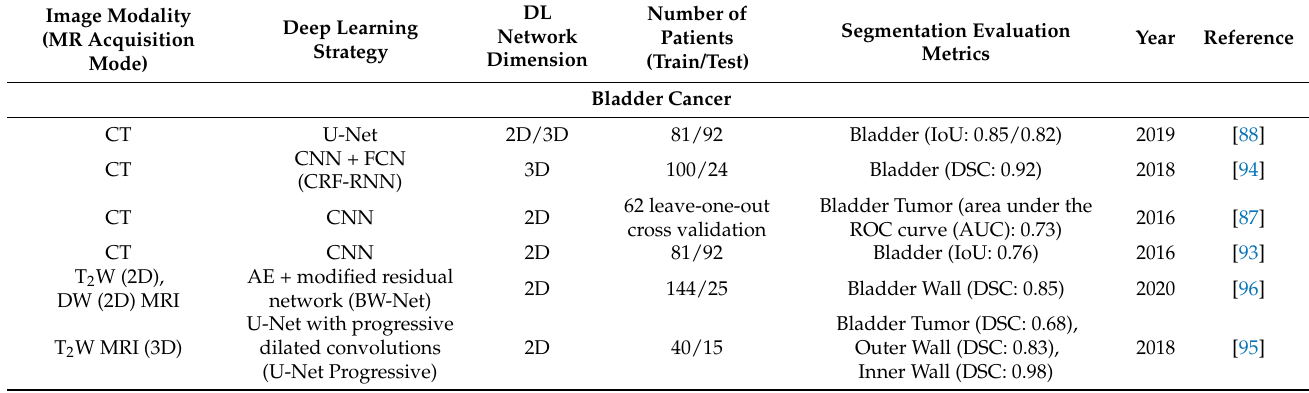
Table 1. Summary of previous publications using DL-based automatic segmentation separated by pelvic anatomical regions (Bladder: 6, Cervix: 7, Prostate: 52, Rectum: 9 studies). The DSC and IoU are shown, where reported, with the DSC metrics in bold (for studies with multiple test results, the metrics calculated on public/external databases are presented). For studies that reported neither DSC nor IoU, the metrics used by the authors are included. MRI acquisition modes (2D, 3D) were retrieved based on the information provided in each published article and/or supplementary